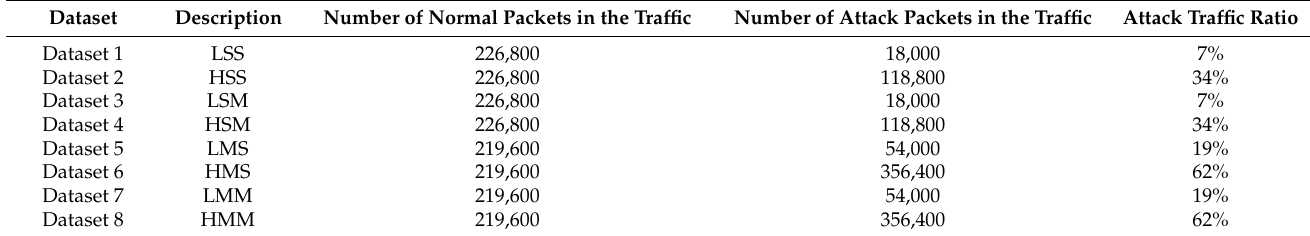
Table 2. Total number of normal and attack traffic packets for eight different